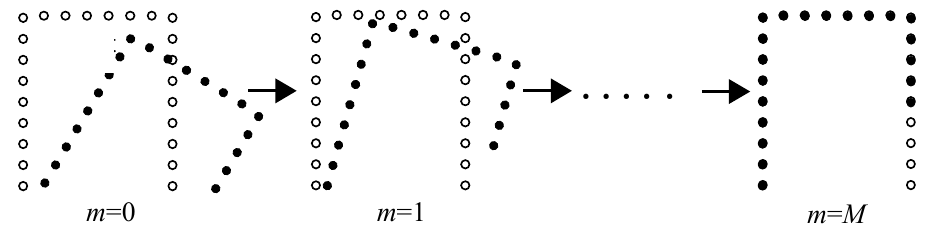
Figure A1. Relative-scan matching. Solid and open circles indicate scan images taken by robots #1 and #2,